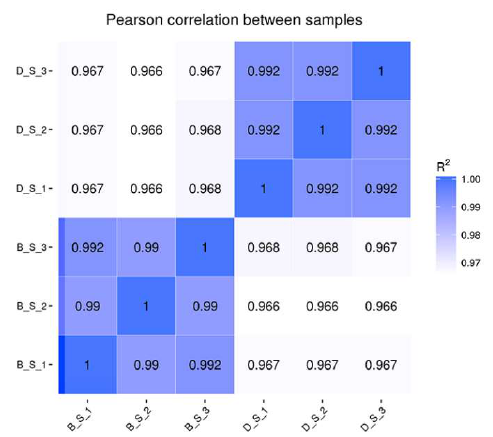
Figure 1. Pearson correlation between samples.